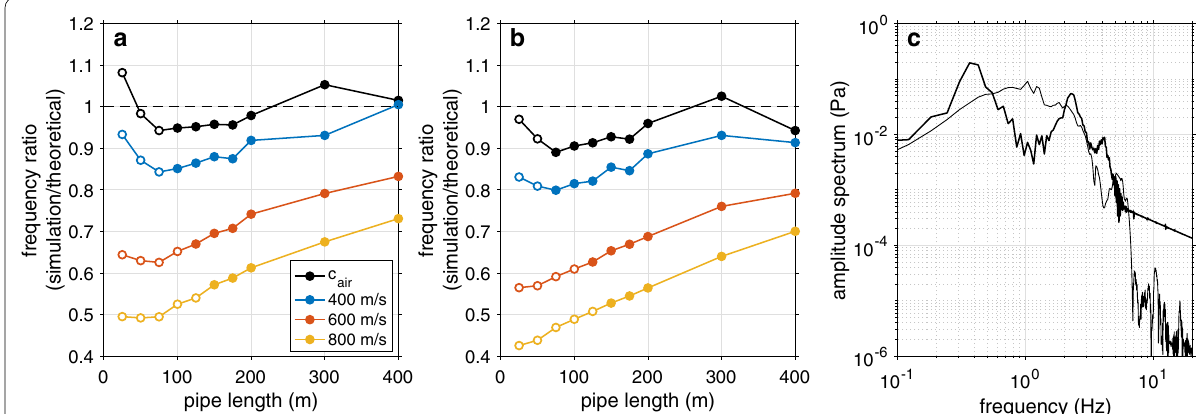
Fig. 3 Frequency ratio of the fundamental resonant frequency between the theoretical values and numerical simulation results. The theoretical frequencies are calculated from Eq. (1). The simulations were performed under two conditions (Additional file 2: Figs. S2–3): a a frustum pipe is connected to a flat plane, and b a frustum pipe is situated at the center of the crater floor of Aso volcano. These figures show the cases, where the closed radius of the frustum ( a c ) is 58 m. The sound velocities inside the vent were assumed to be 400 m/s, 600 m/s, 800 m/s, and c air (1-D profiles of the velocities are shown in Additional file 2: Fig. S2–2). At the high velocity inside the vent, the computed fundamental frequency is lower than the theoretical value ( a , Additional file 2: Fig. S2–4d). The computed fundamental frequency with topography becomes slightly lower than that with a flat plane ( b ). The pipe lengths, indicated by the white-filled circles, cannot produce any overtone peaks of the amplitude spectra. c Amplitude spectra obtained from the simulations when c = 600 m/s and a c = 58 m (with the volcanic topography). The black line shows the spectrum when the pipe length is 150 m, and the thin gray line shows the spectrum when the pipe length is 25 m. The spectral structure of the 150-m pipe is very similar to the observed structure (Fig. 2a). However, a very short pipe cannot make a clear two-peaked spectral structure such as that